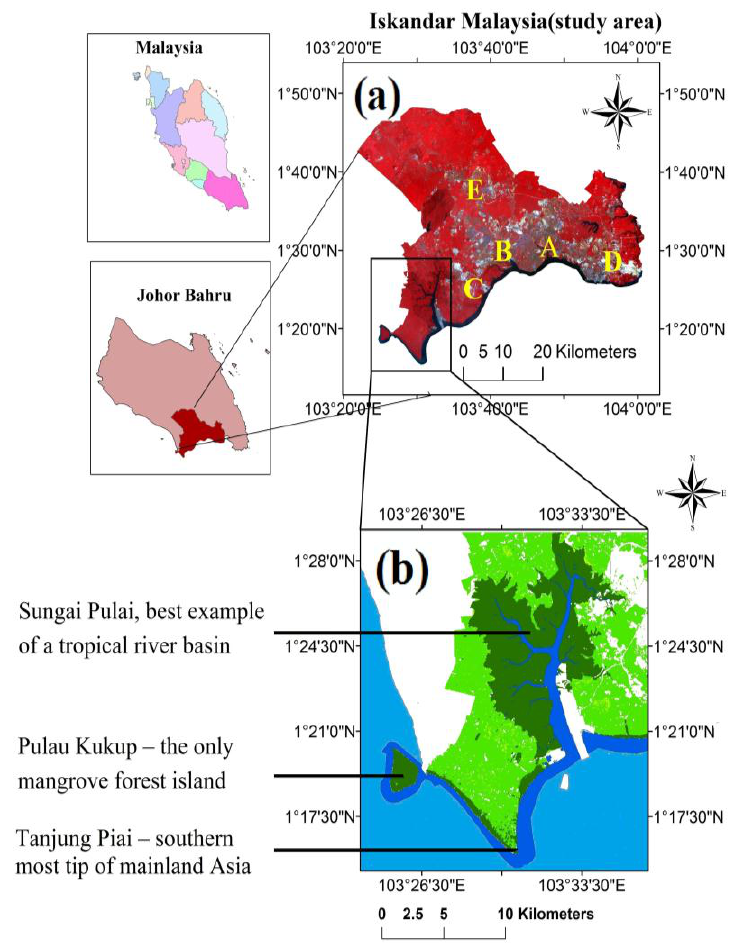
Figure 2. ( a ) The Iskandar Malaysia (IM) region in Johor State of Peninsular Malaysia shown by a Landsat image (the five flagship zones are marked as A–E); and ( b ) the three Ramsar sites in IM (source: Comprehensive Development Plan